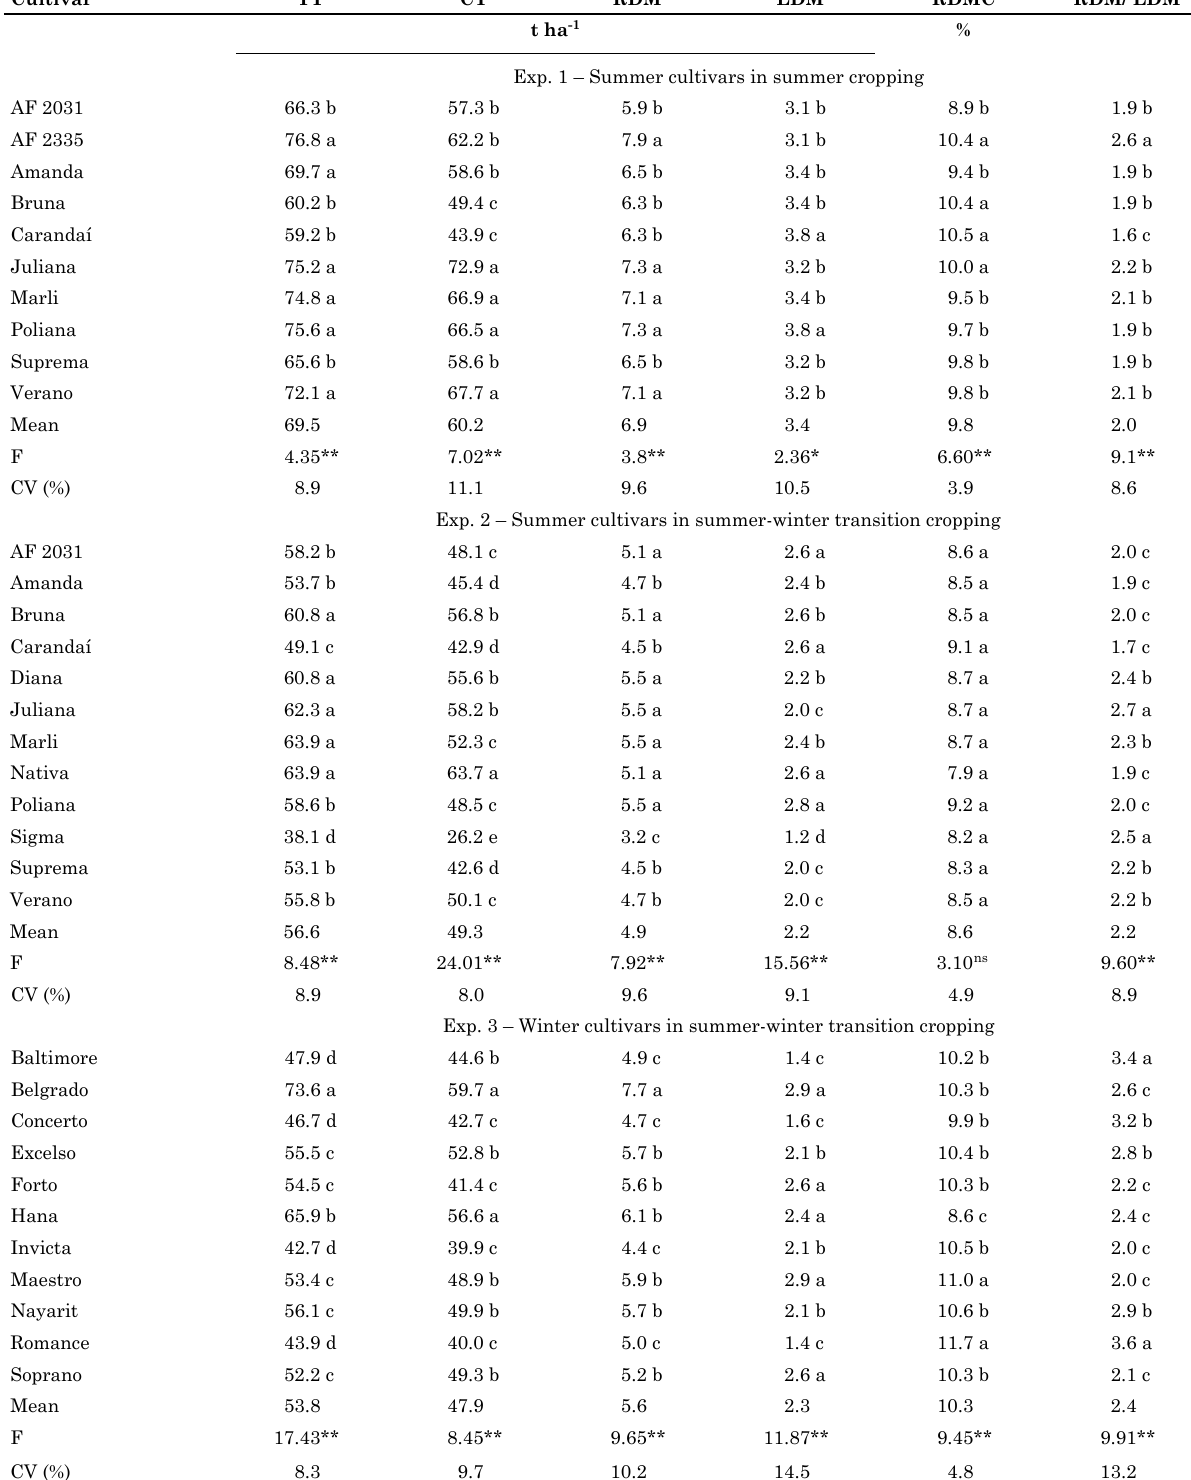
Table 2. Total yield (TY) and commercial yield (CY) of roots, root dry matter (RDM) and leaf dry matter (LDM), root dry matter content (RDMC), and ratio of root dry matter and leaf dry matter (RDM/LDM) in summer carrot cultivars in summer cropping (Experiment 1), and in summer and winter cultivars in summer-winter transition cropping (Experiments 2 and